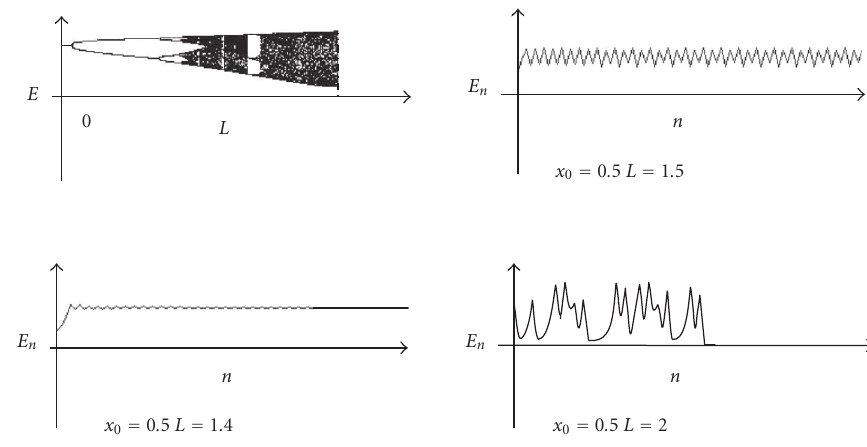
Figure 3.3. Stages of transition to deterministic chaos of pressure pulses simultaneous